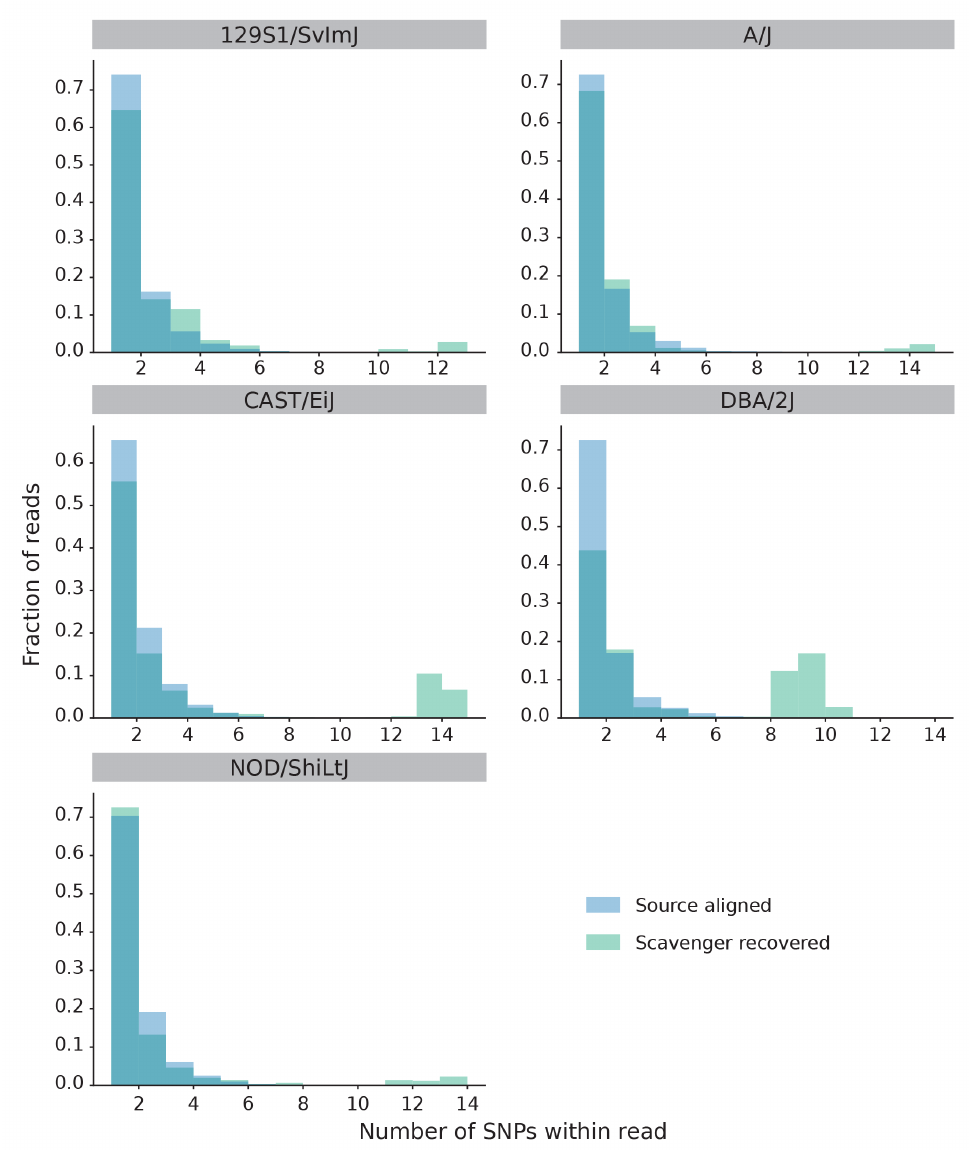
Figure 3. Distribution of number of SNPs found within source aligned reads and Scavenger recovered reads for each non- reference mouse strain. Scavenger is able to recover reads with a higher number of SNPs (> 5) compared to source